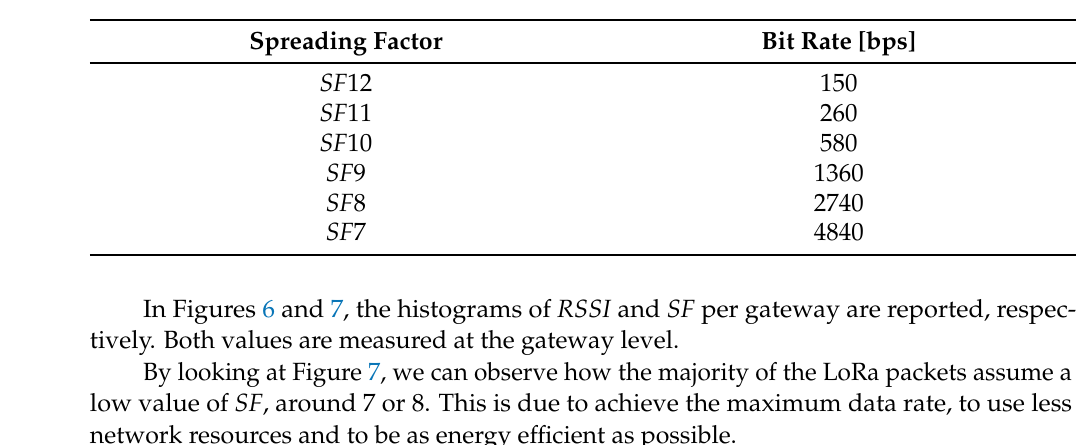
Table 4. Table reporting spreading factor values with relative bit rate. [4]. In this table we use the 125kHz bandwidth channel.